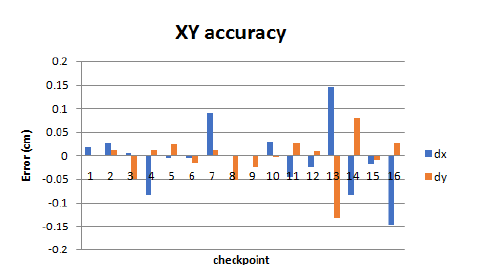
Figure 9: DSM - (left) autonomous mode, (right) after replacing underneath elevation